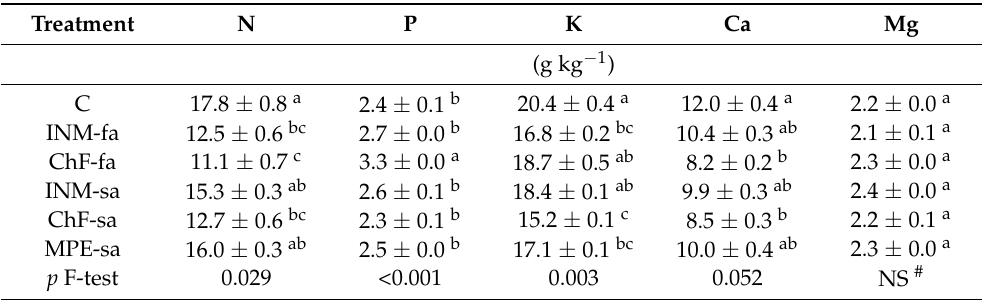
Within each column different letters indicate significant differences. # NS: